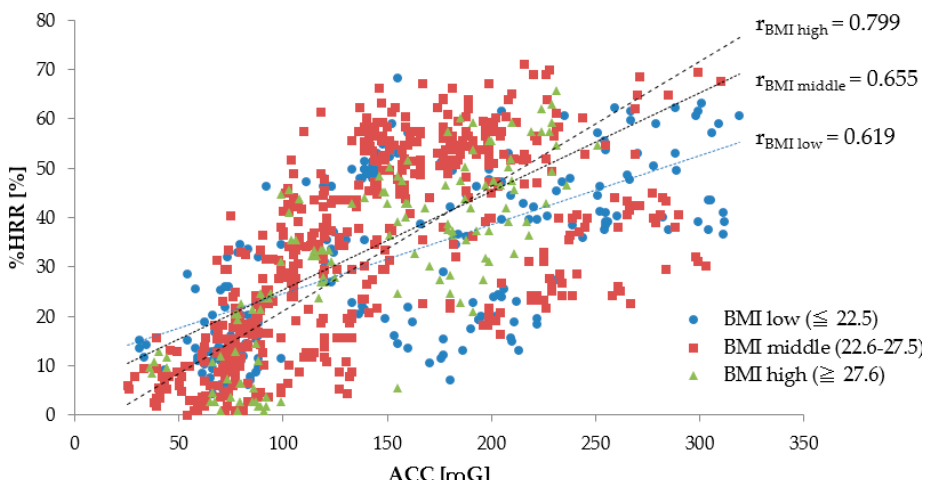
Figure 4. Relationship between ACC and %HRR (Workers’ BMI levels are ≤ 22.5 kg / m 2 , 22.5–27.5 kg / m 2 , and ≥ 27.6 kg / m 2 ). r low, r middle , and r high are the correlation coe ffi cients of the relationship between ACC and %HRR, for ≤ 22.5 kg / m 2 , 22.6–27.5 kg / m 2 , and ≥ 27.6 kg / m 2 .